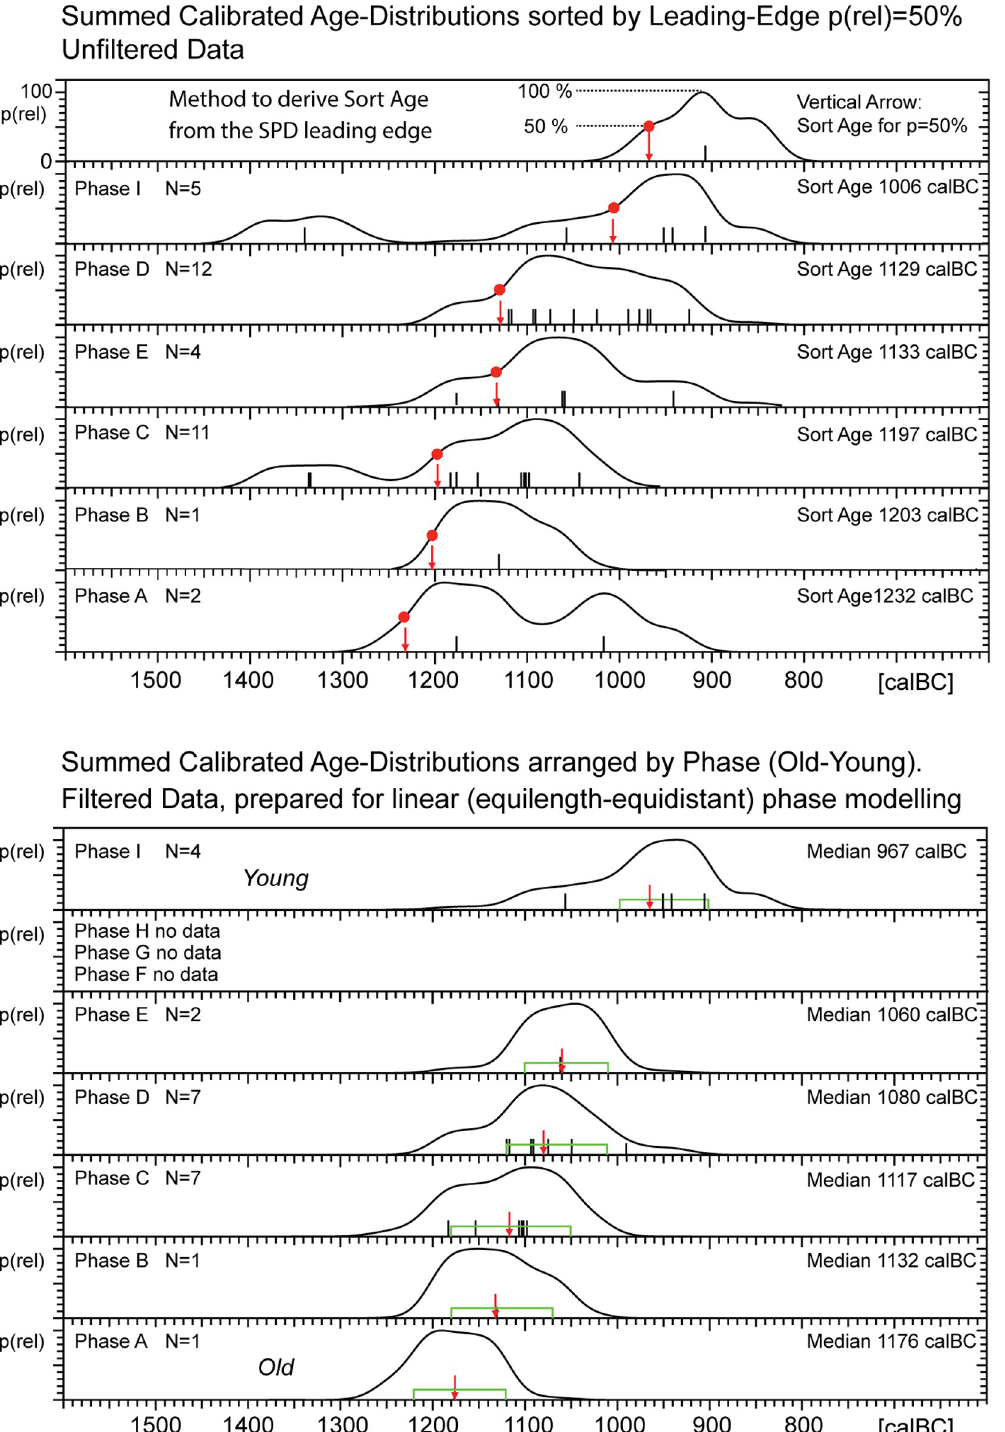
Fig 11. Stratigraphic integrity of Sidon data (Table 1), evaluated by SPD-sequencing. ( Upper Graph) : The SPDs of each Sidon Phase (A,B,C,D,E,I) are arranged according to their known stratigraphic sequence, from oldest to youngest. The lowest SPD is for Phase A (N = 2 dates), the uppermost SPD is for Phase I (N = 4 dates). The known SPD-order is used to derive a specific SPD-amplitude that is valid for the SPDs of all phases, and which can be used to automatically sort the SPDs. All SPDs are assigned a common max amplitude (p = 100%). Then there also exists a common amplitude of p = 50%, that can be